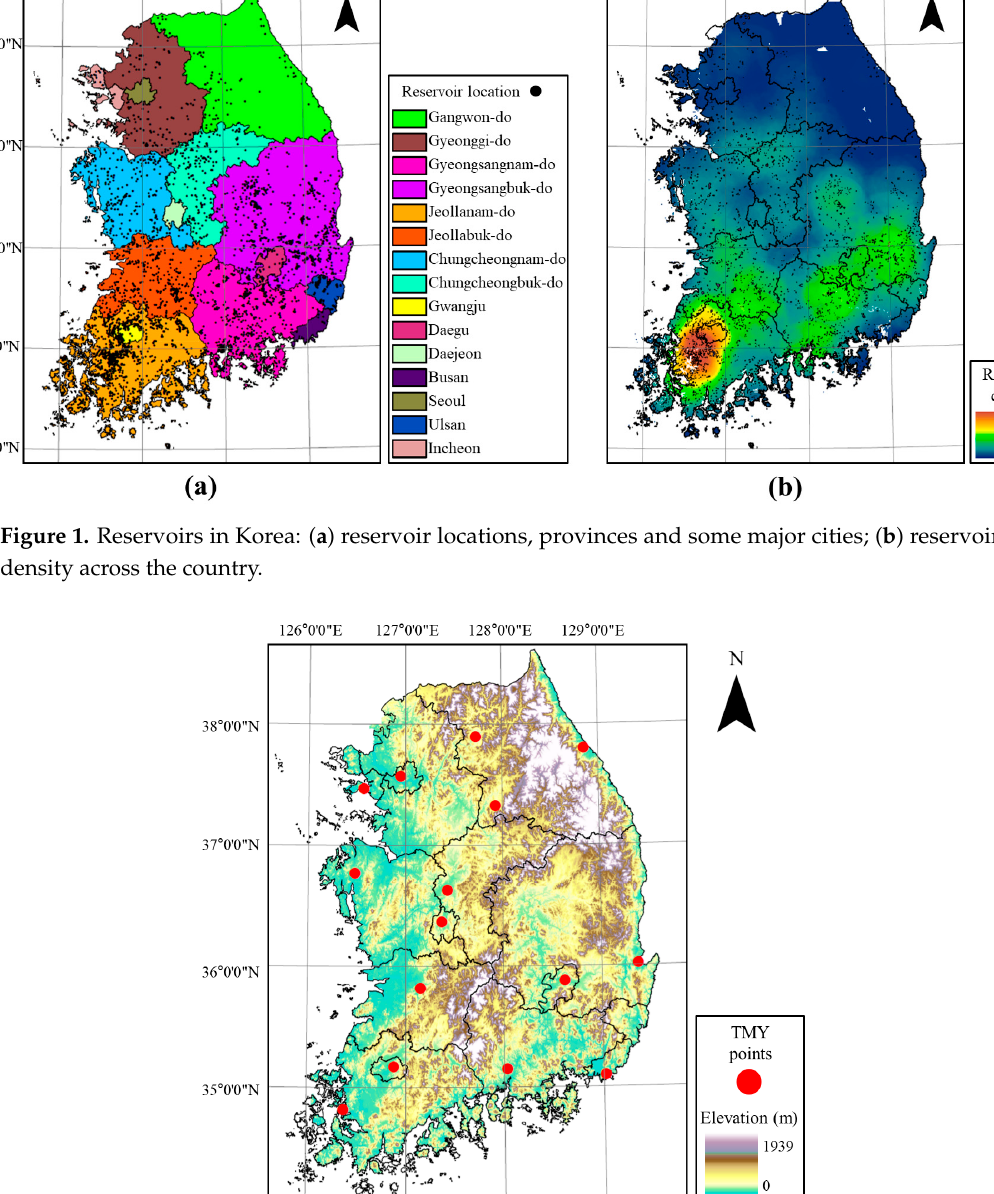
Figure 3. Overall study process to select suitable reservoirs and assess the potential of floating photovoltaic systems in Korea.